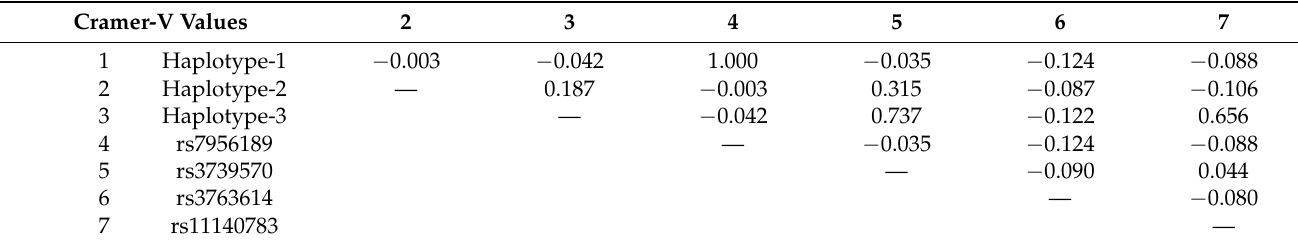
Table 3. Association of the genetic variables in the study ( n = 146).